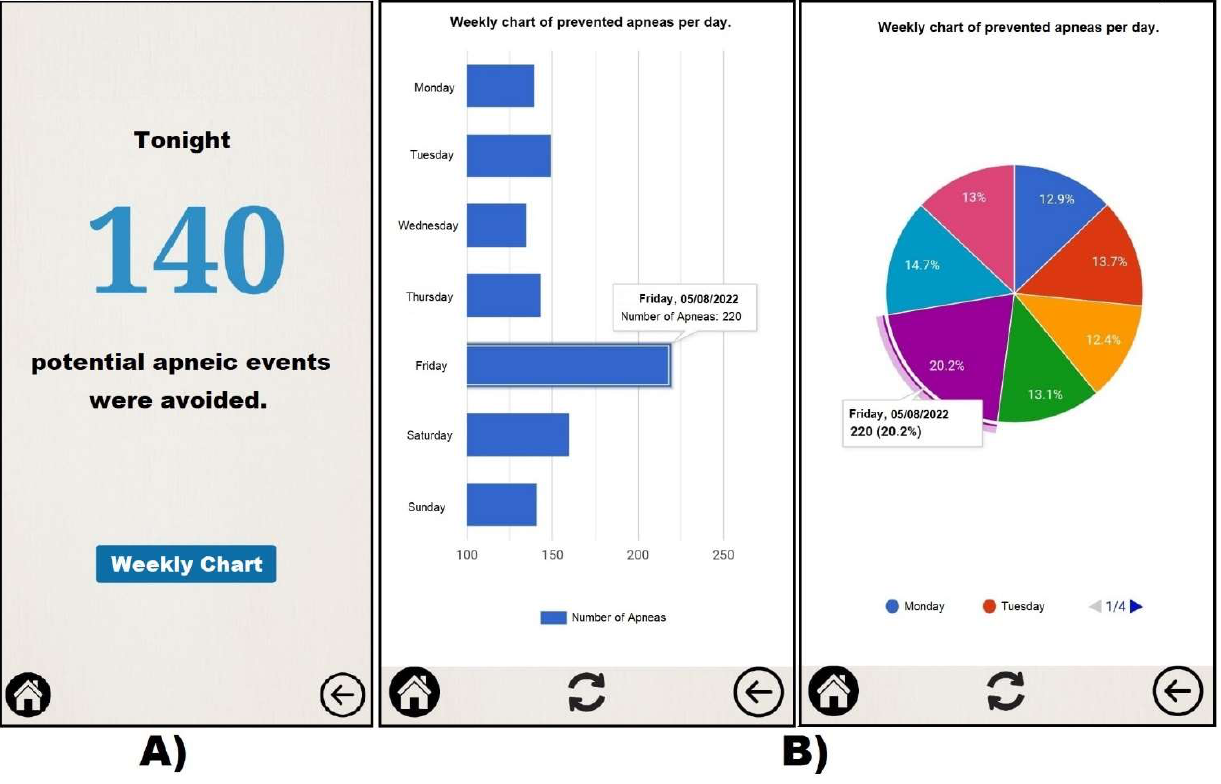
Figure 13 . ( A ) Application ’ s daily log window and ( B ) application ’ s bar graph and circle graph Figure 13. ( A ) Application’s daily log window and ( B ) application’s bar graph and circle graph windows.